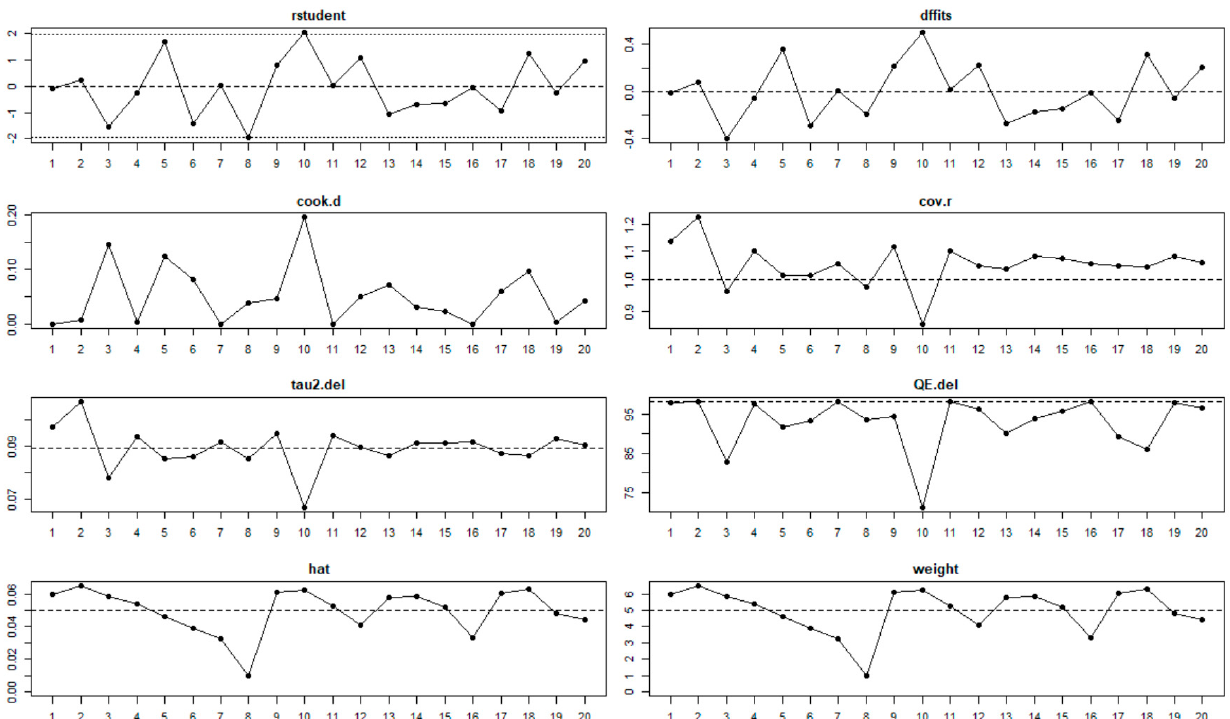
Figure 5. Baujat plot showing that no single study influences the results.